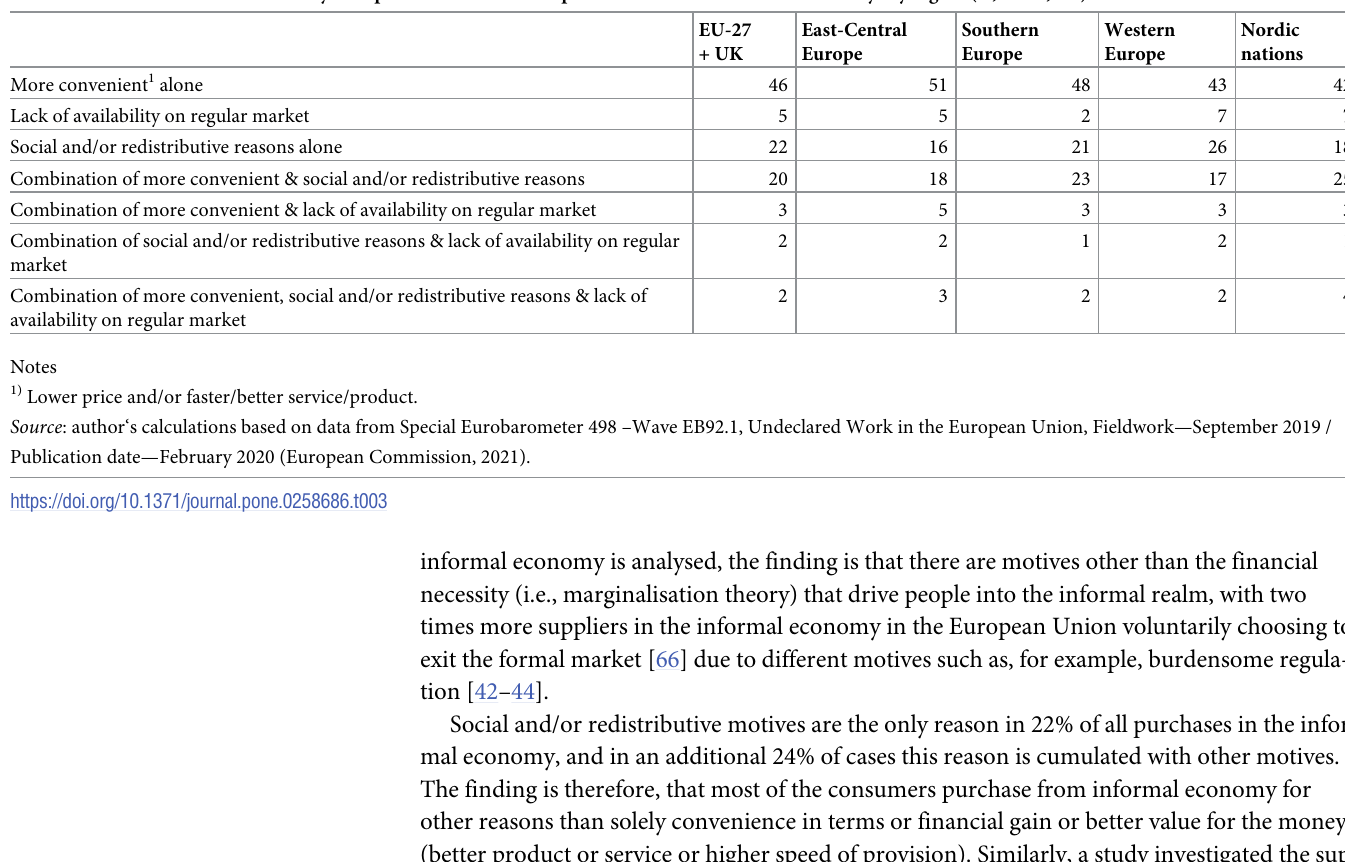
Table 3. Combinations of reasons why European consumers make purchases from the informal economy: By region (%; N =